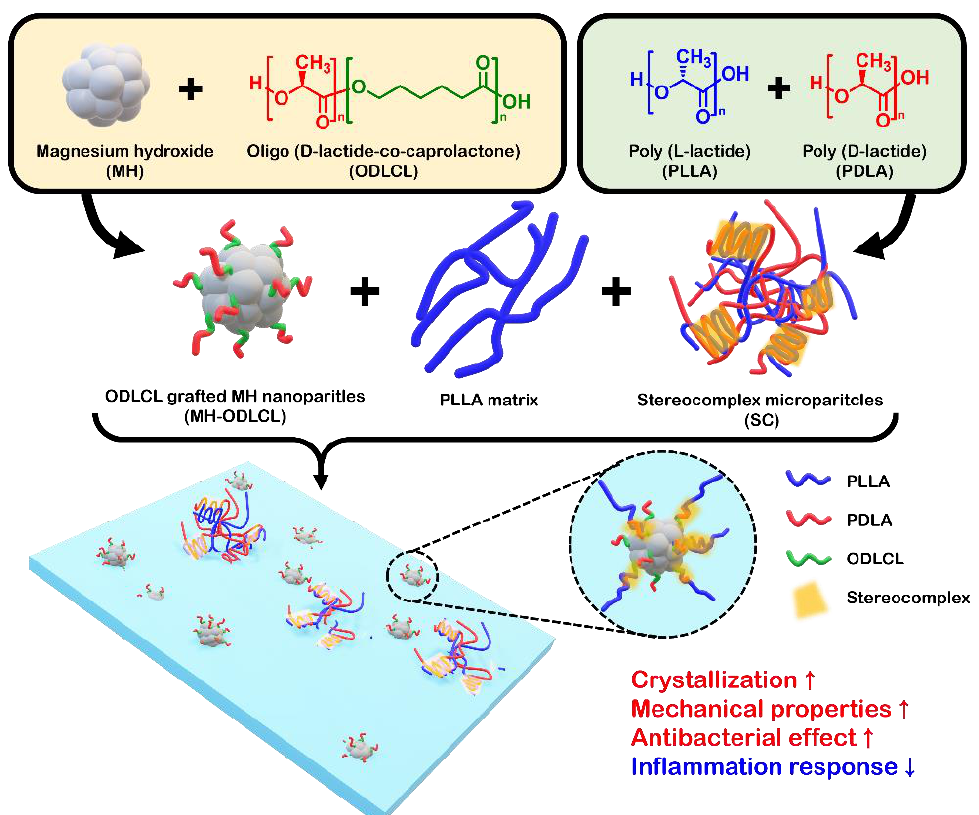
Figure 1. A schematic illustration of the preparation of the PLLA composites. The surface of MH was modified with ODLCL, and the SC were fabricated using PLLA and PDLA. The PLLA compos- ites contained surface–modified MH and SC to provide anti–inflammatory effects and improved mechanical properties.